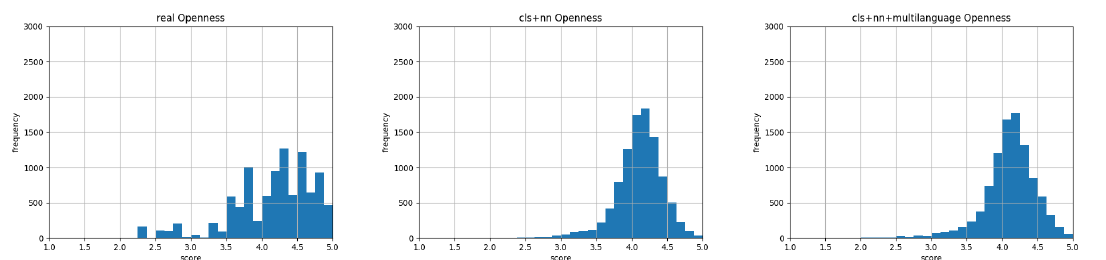
Figure 11. Openness: Histograms representing data distribution of gold standard on the left, our English model result in the middle, and our multilingual model result on the